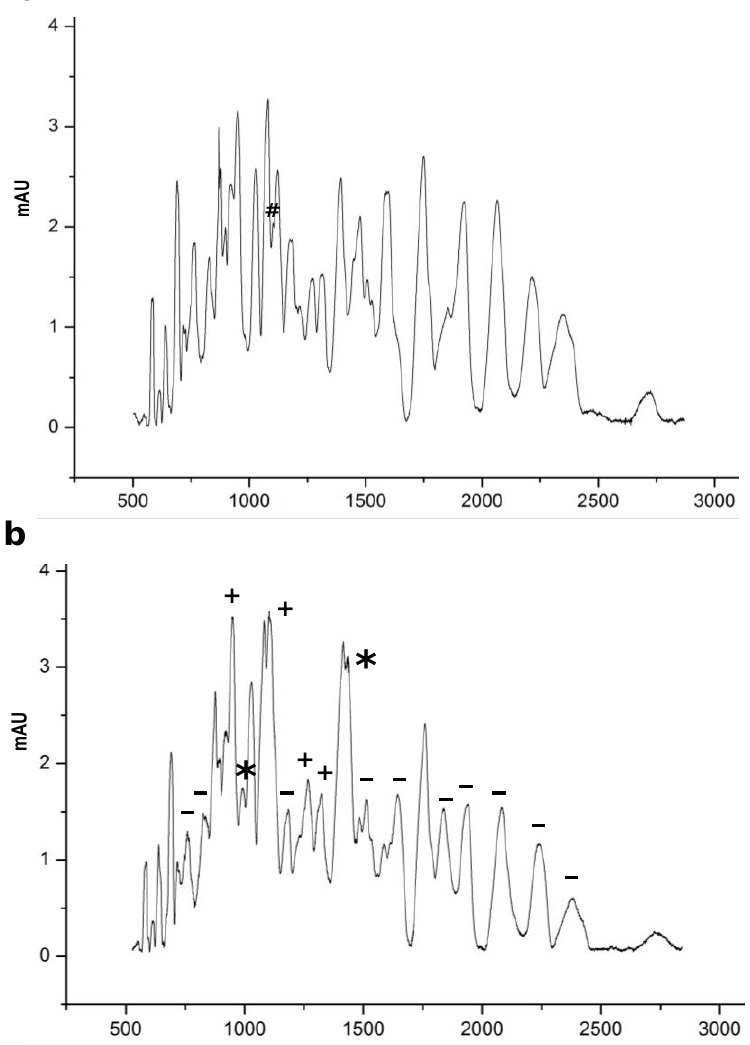
Figure 3. CZE profiles of peptide extracts with MWCO ≤ 1 kDa derived from pepsin, trypsin, chymotrypsin and peptidase hydrolysis of ( a ) nWPH and ( b ) pWPH. The symbols identify extra peaks found in pWPH hydrolysates (*) and indicate differences in the relative abundances of peptides as a result of pressure treatment (+, higher abundance, −, lower abundance in pWPH relative to nWPH; #, peak found in nWPH but not in pWPH